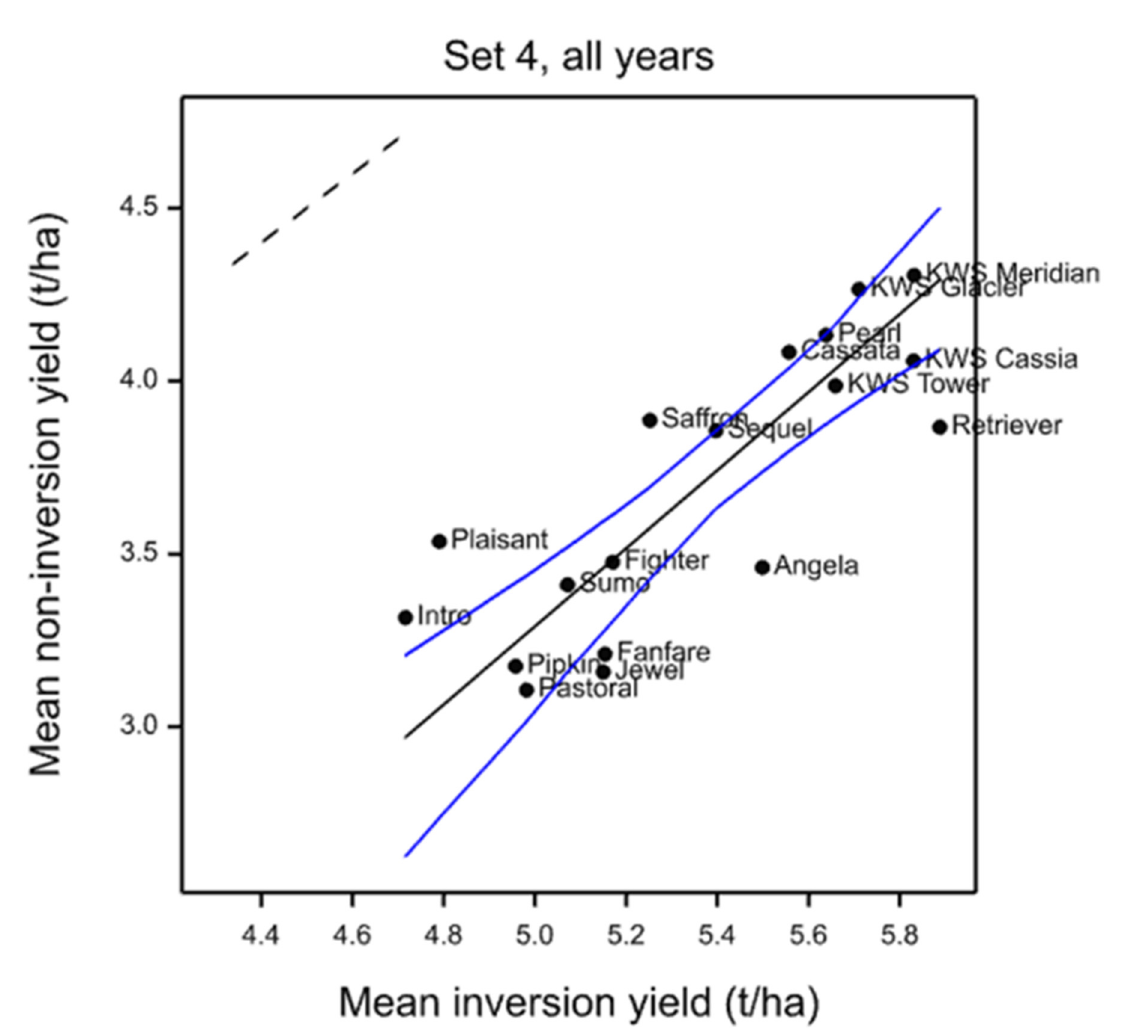
Figure 6. Regression of non-inversion yield on inversion yield for 18 winter barley cultivars from 2011 to 2014. The blue lines show the 95% confidence interval of the functional regression line (solid black), while the dashed line shows the 1:1 yield ratio.